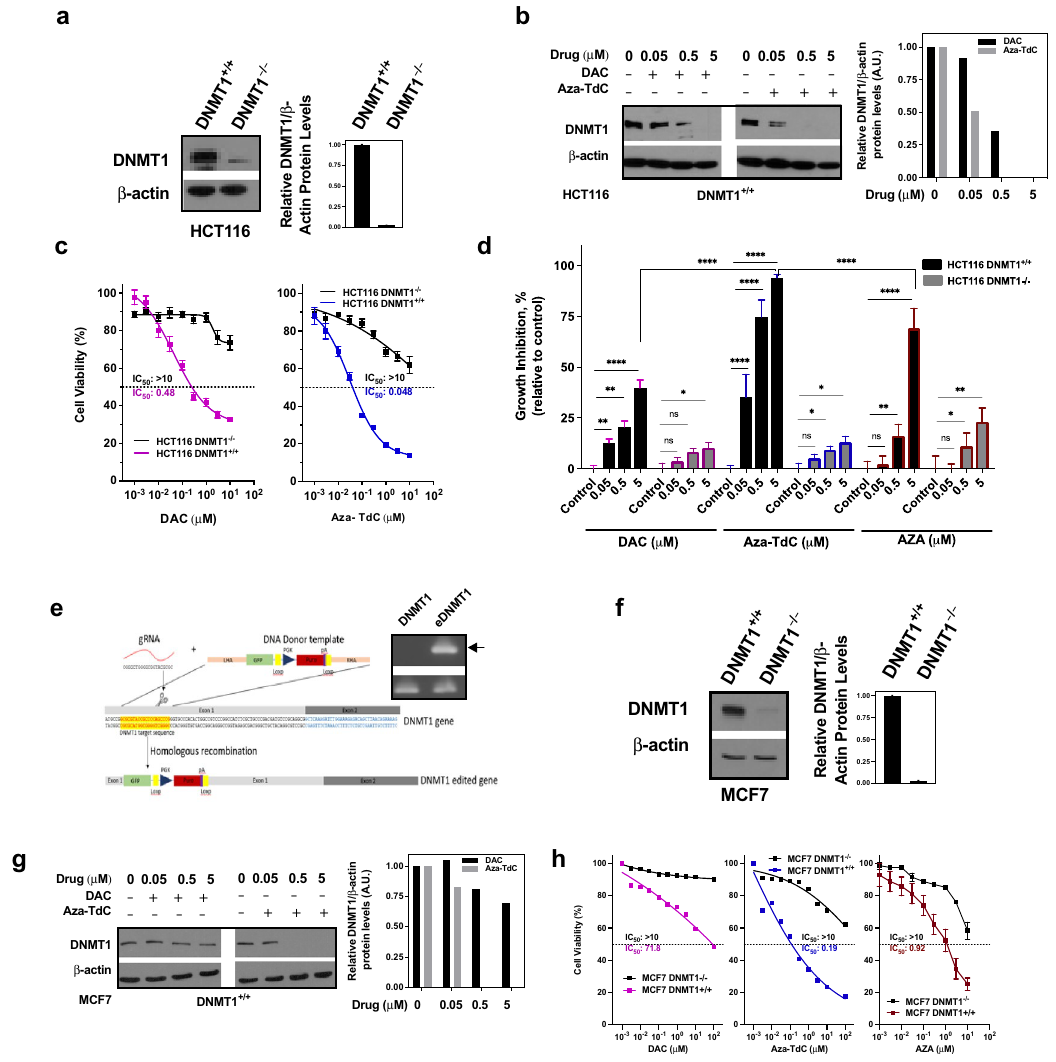
Figure 1. Effects of DNMTi on DNMT1, cytotoxicity and growth in models with intact and disrupted DNMT1 gene. ( a ) Western blotting analysis and quantitation of DNMT1 in HCT116 DNMT1 +/+ and DNMT1 −/− cells. ( b ) Inhibition of DNMT1 following exposure to DAC and aza-T-dCyd for 48 h in HCT116 DNMT1 +/+ cells. ( c ) Cytotoxicity of DAC and aza-T-dCyd after treatment for 96 h in the HCT116 pair. ( d ) Colony formation inhibition of HCT116 pair by three inhibitors as indicated. ( e ) Scheme of disruption of DNMT1 gene using CRISPR technology in MCF7 cells. Inset: PCR confirmation of genomic integration of the donor template DNA (arrow: 379 bp insertion, eDNMT1) into the DNMT1 gene relative to the scrambled control. ( f ) DNMT1 phenotype in the MCF7 pair probed with DNMT1 antibody. ( g ) Inhibition of DNMT1 protein by DAC and aza-T-dCyd in MCF7 DNMT1 +/+ cells after 48 h of drug exposure. ( h ) Cytotoxicity of DAC, 5-aza-T-dCyd and AZA in the MCF7 cell pair. All samples in the cytotoxicity and colony formation experiments were assayed in triplicate, with at least three independent experiments performed, and data were shown as mean ± SD. * P < 0.05; ** P < 0.01; **** P < 0.0001; and ns, not significant. One representative experiment is shown from at least three independent experiments for other